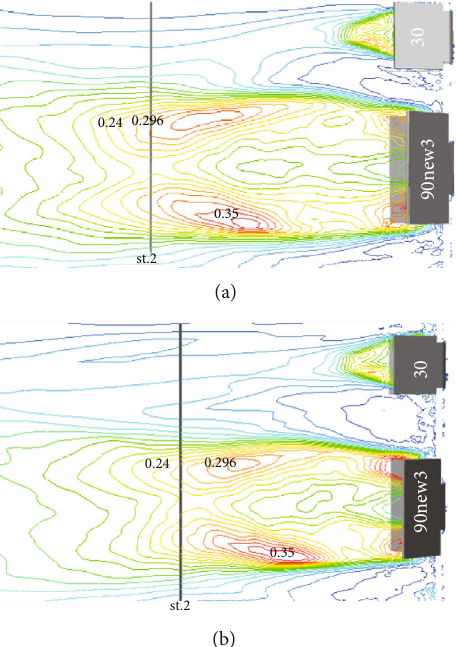
ff erent characteristic widths: (a) CW = 2 : 12 and (b)